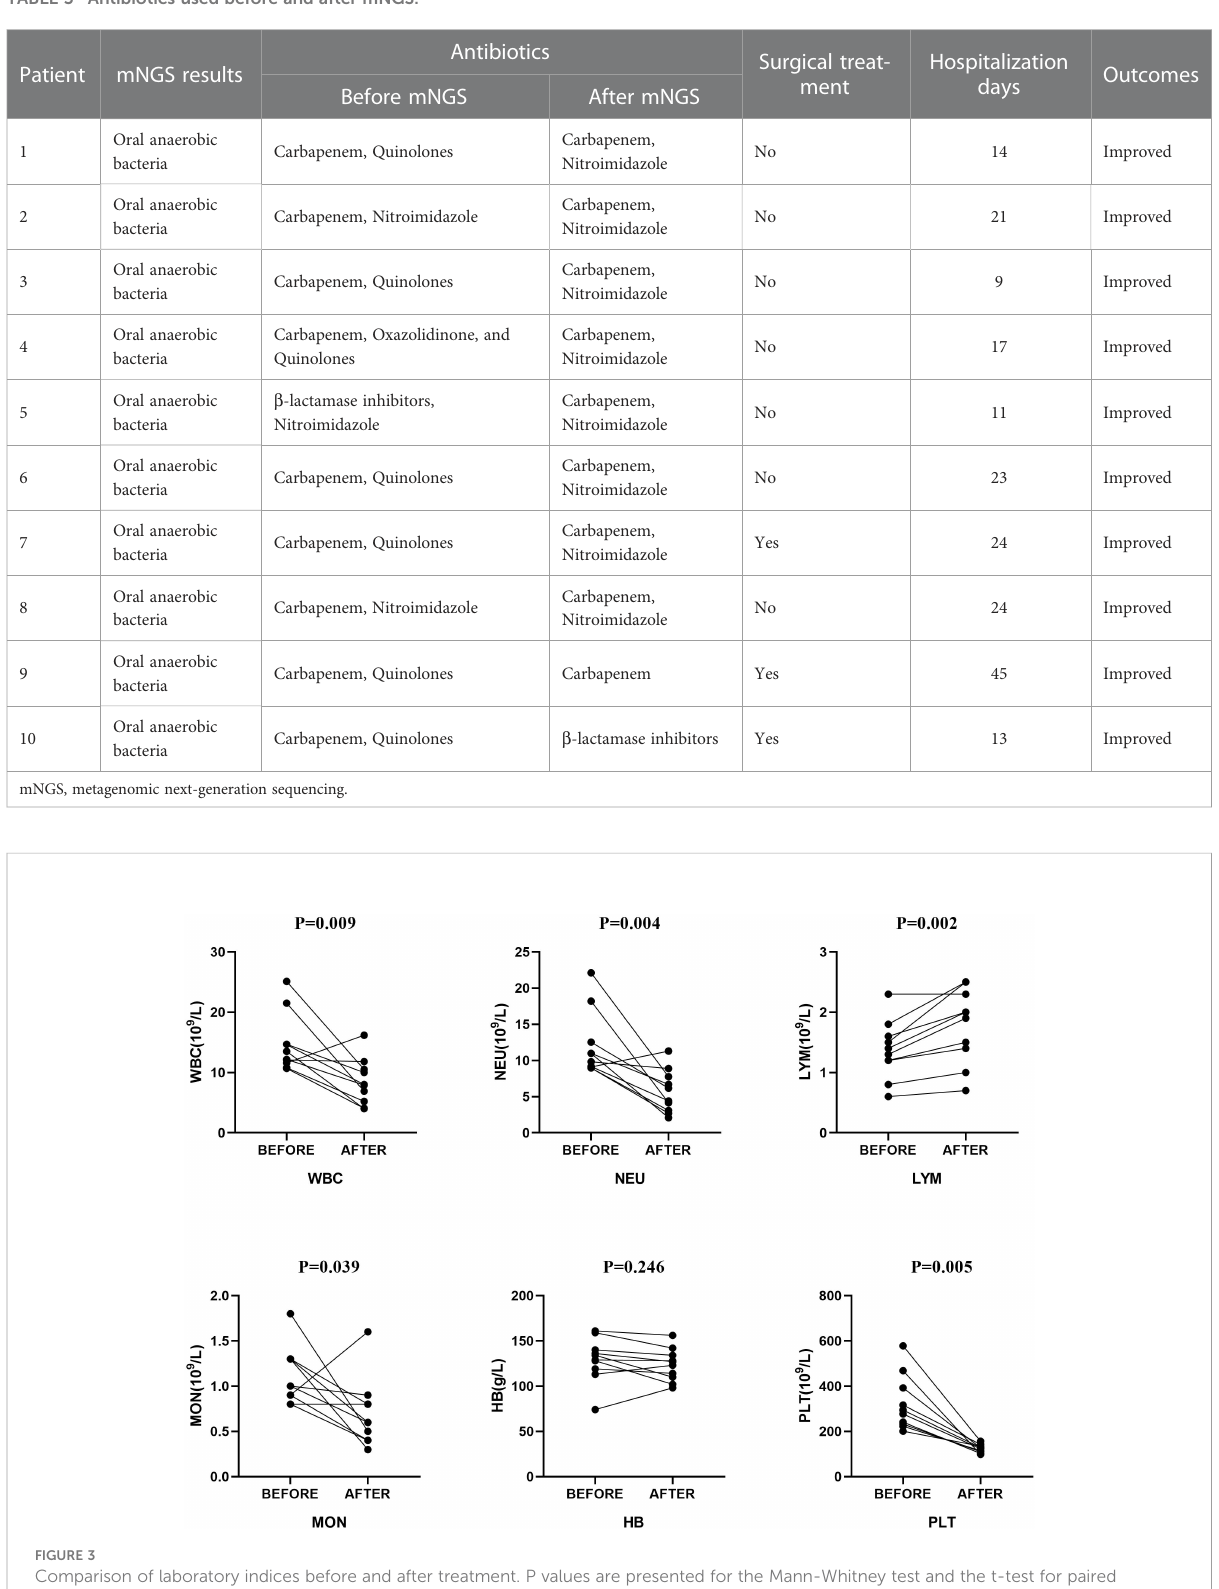
TABLE 3 Antibiotics used before and after